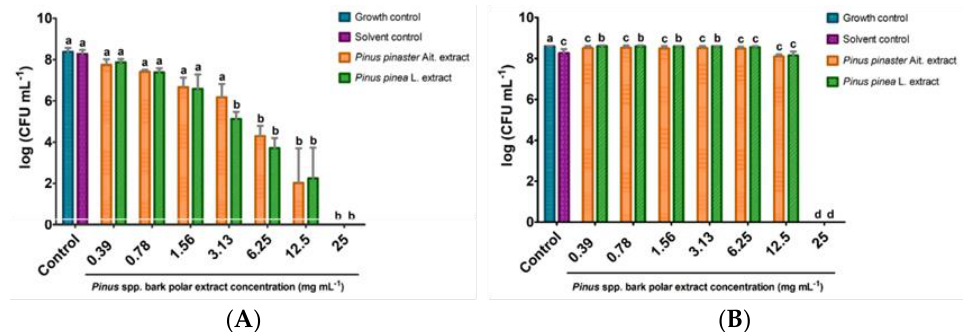
Figure 2. Inhibitory effect of Pinus pinaster Ait. and Pinus pinea L. bark polar extracts against the growth of ( A ) S. aureus (ATCC ® 6538) and ( B ) E. coli (ATCC ® 25922). The solvent control represents the bacterial growth under 12.5% ( v / v ) ethanol. The columns and bars depict, respectively, the mean and the mean-standard of the error of three independent experiments performed in triplicate. Columns with different letters are statistically different from the solvent control (unidirectional ANOVA followed by Duncan’s Test; p < 0.05). CFU, colony forming units.